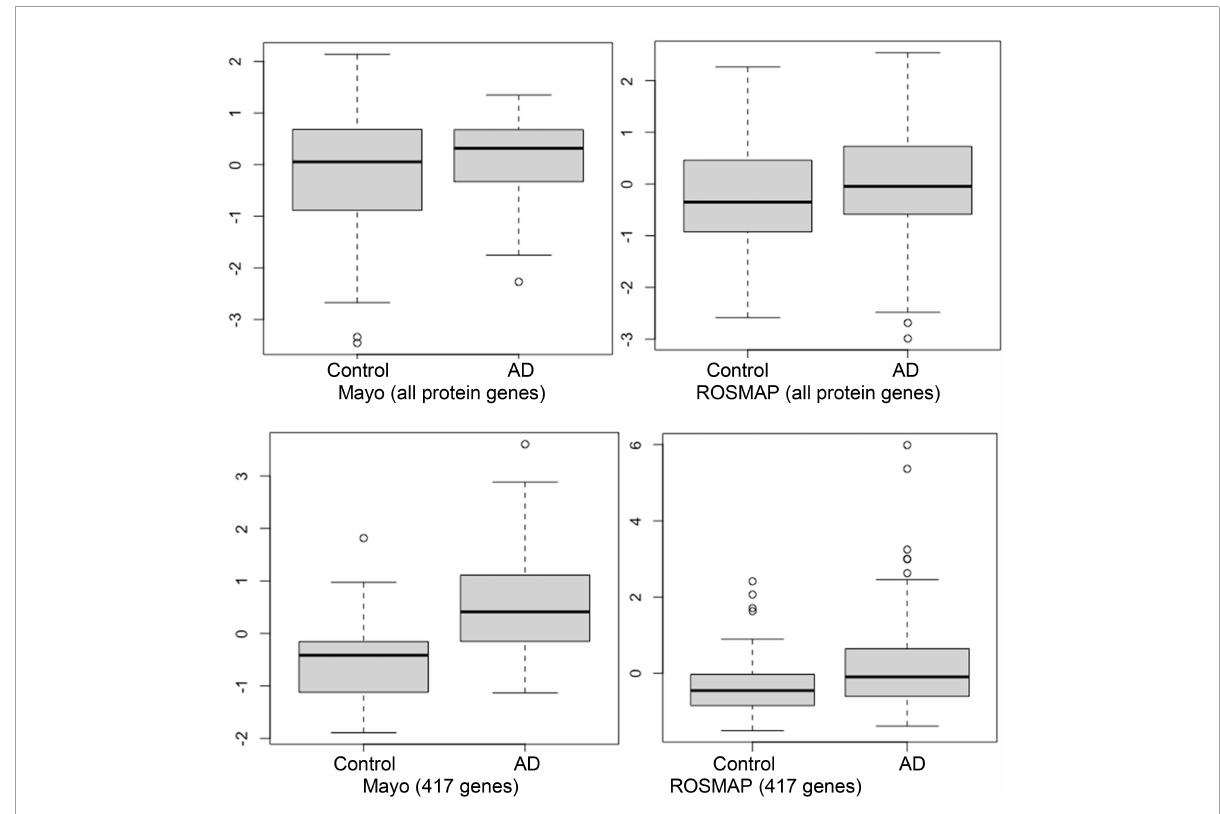
FIGURE2 Box plots of the first principal component of MDS analysis in control and AD cases. Left and right columns are Mayo and ROSMAP samples, respectively. Upper and lower panels represent the MDS analysis using all genes and 417 upregulated genes, respectively. Y -axis is the first principal component of MDS analysis.